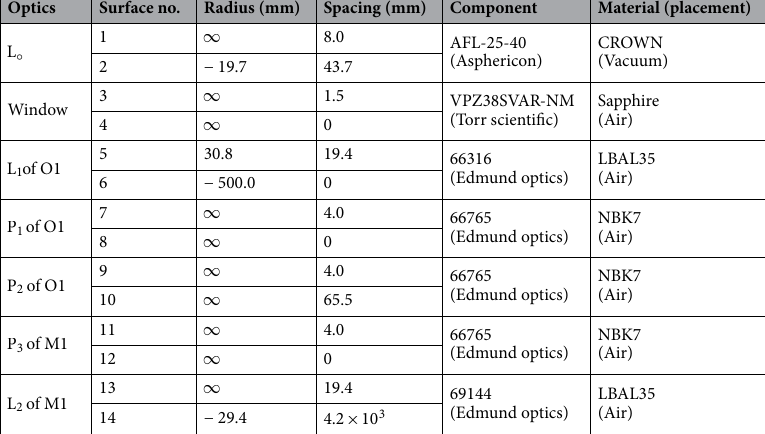
Table 2. Specifications of the L